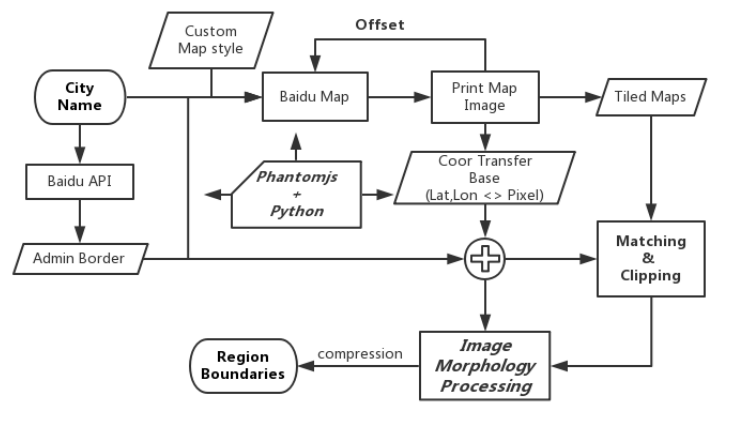
Figure 4. Framework for download map data from the Baidu Map